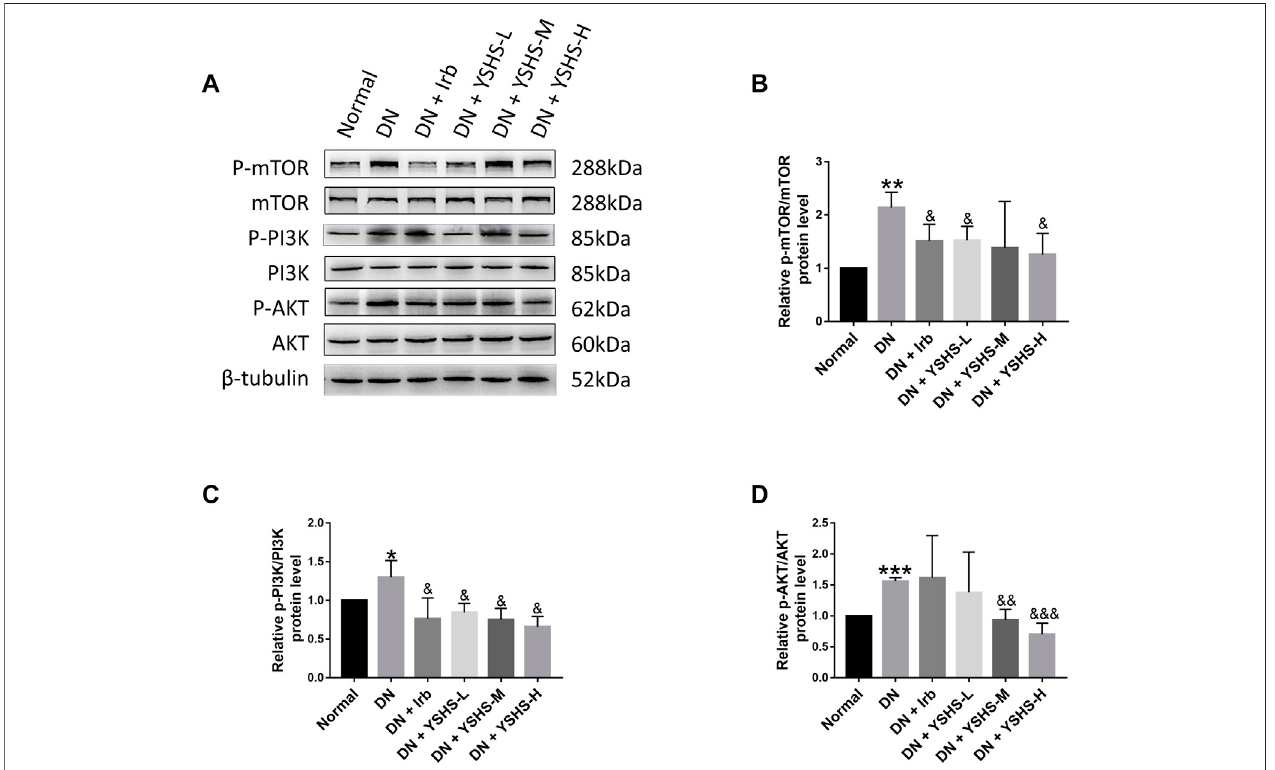
FIGURE 6 | Western blot analysis of PI3K/AKT/m-TOR signaling pathways (A) . Relative expression and activation of mTOR (B) , PI3K (C) , and AKT (D) was analyzedby theImageJsoftware. Values arepresented asmeans ±SEM.* p < 0.05, ** p < 0.01, *** p < 0.001, vs. Normal;& p < 0.05, && p < 0.01, &&& p < 0.001, vs. DN.